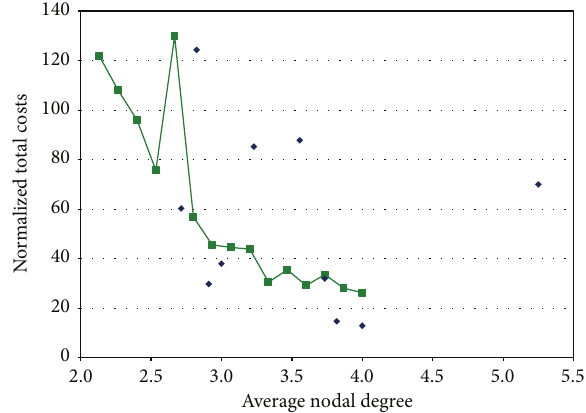
Figure 22: Normalized span restoration SCA spare capacity costs.